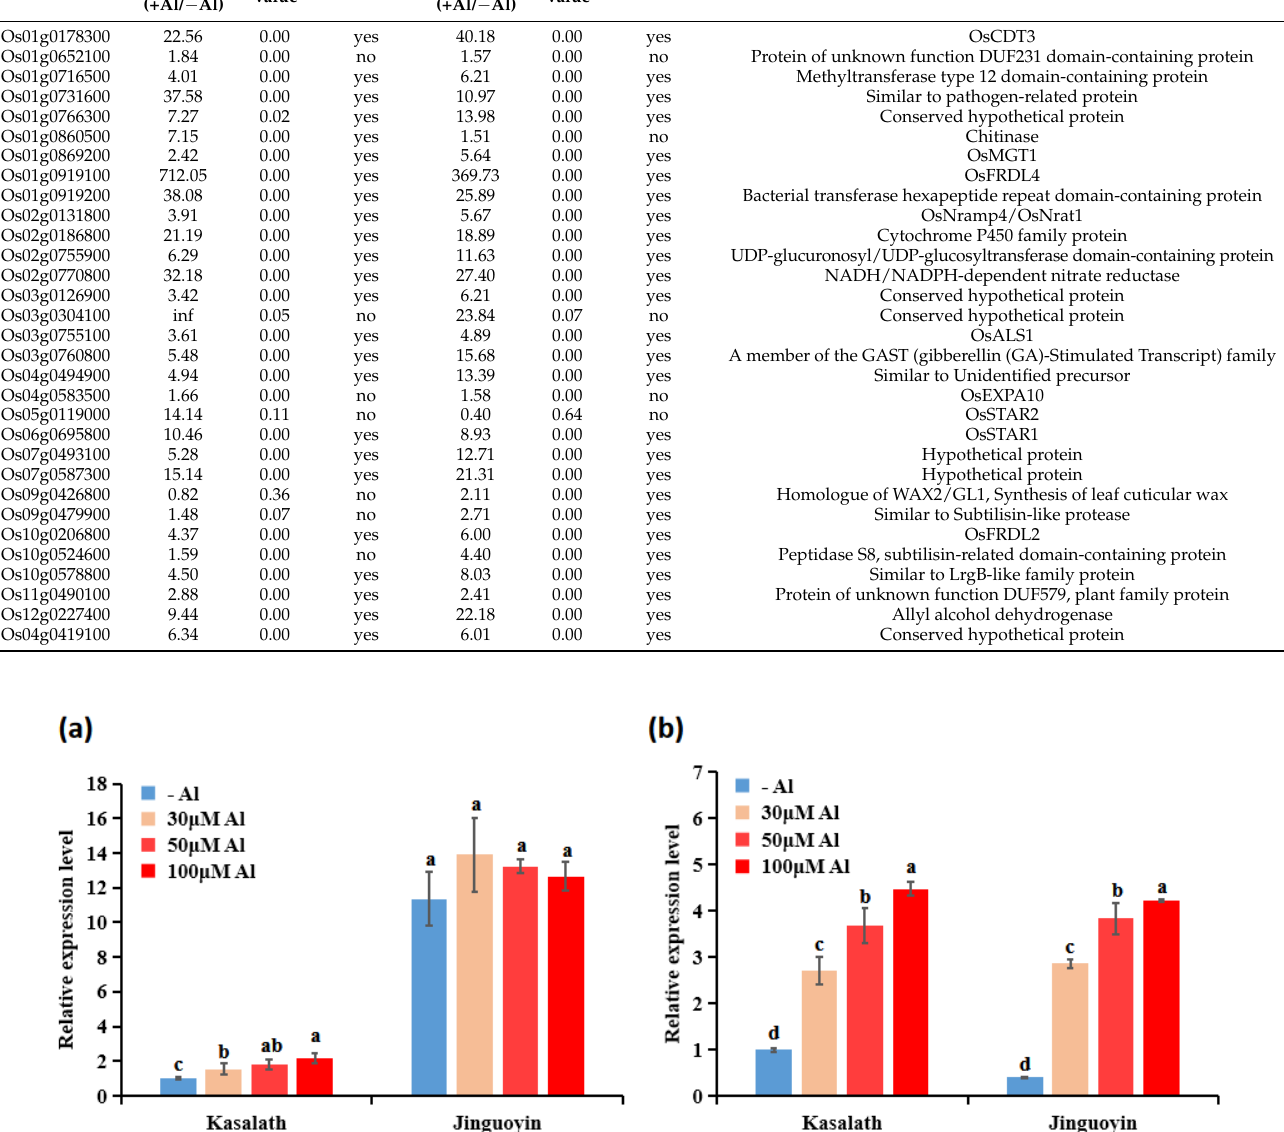
Figure 8. Dose-dependent expression of ART1 ( a ) and ART2 ( b ) in rice roots of Kasalath and Jinguoyin. 4-day-old seedlings were exposed to a 0.5 mM CaCl 2 (pH 4.5) solution containing 0, 30, 50, and 100 µ M Al for 24 h. Data are mean ± SD (n = 3). Different letters indicate significant differences between different treatments in Kasalath and Jinguoyin at p -values <0.05 by Tukey’s test.